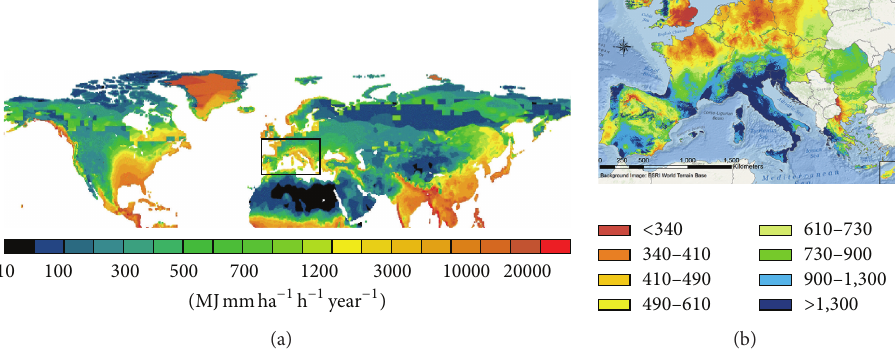
Figure 1: (a) Distribution of long-term mean of the rainfall erosivity (1961–1990) at five-arc-minute resolution (adapted from Naipal et al. [56]) for the Northern Hemisphere, (b) with detailed focus (0.1-arc-minute resolution) on Europe as arranged from European erosivity dataset for the period 2002–2011